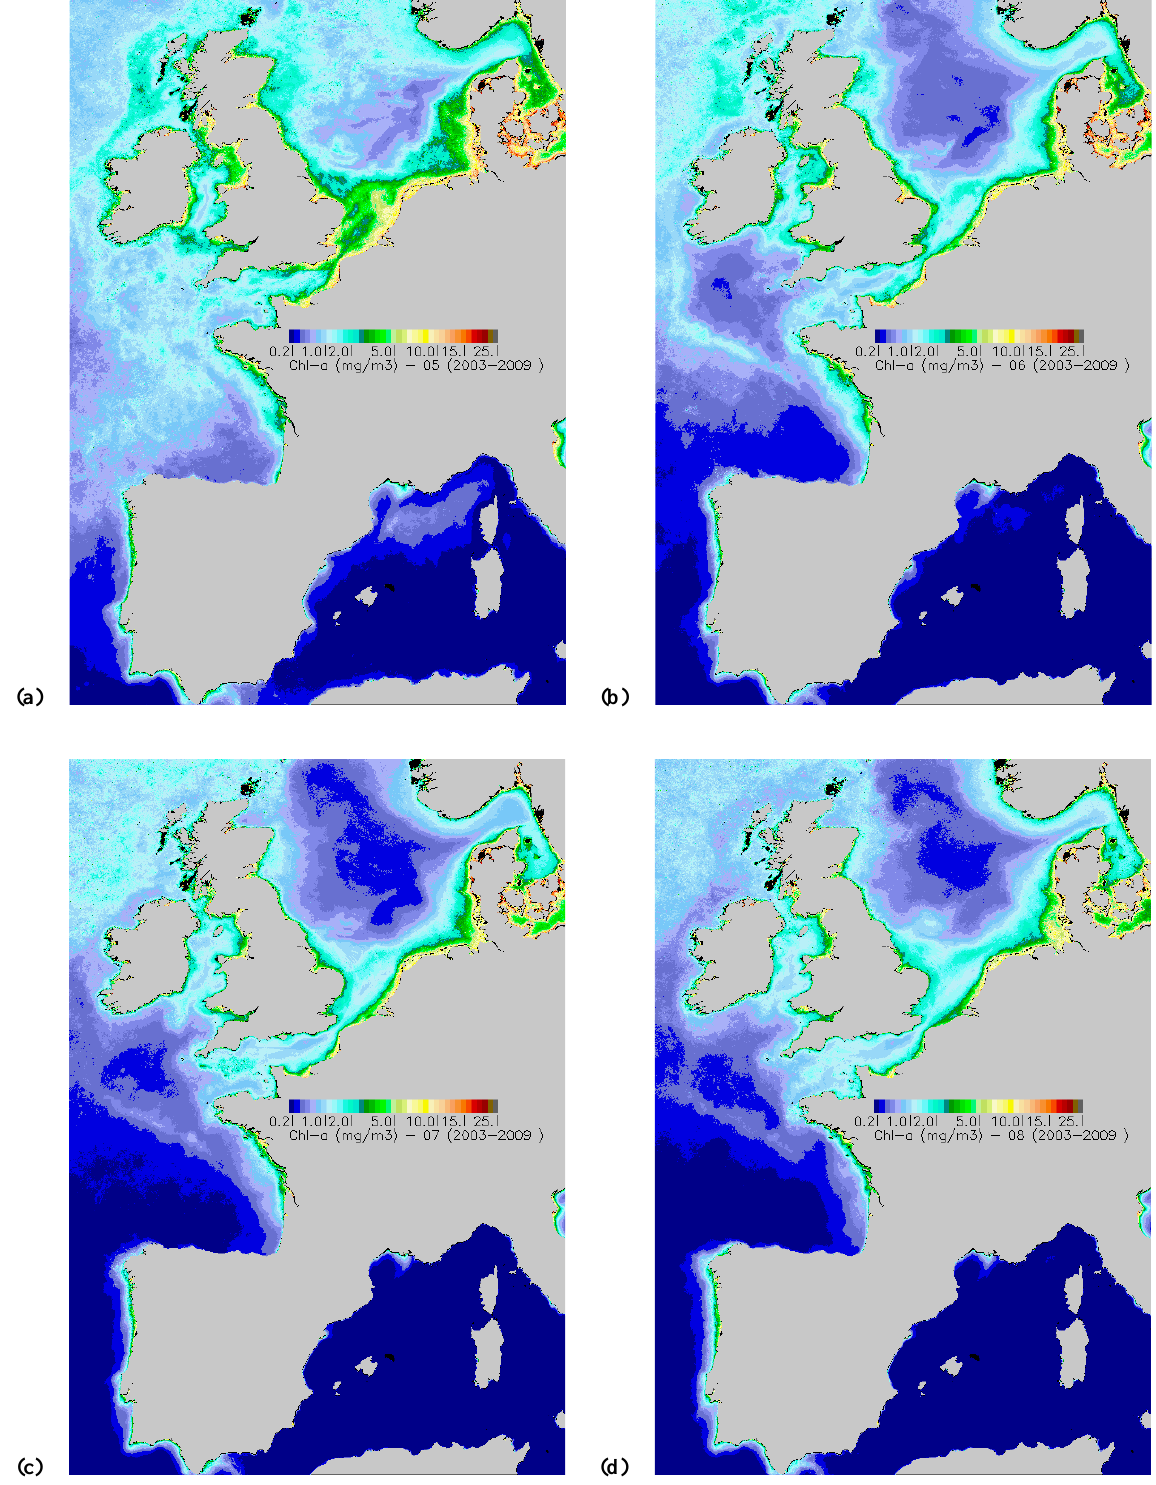
Fig. A2. Monthly chlorophyll- a concentration in May (a) , June (b) , July (c) and August (d)